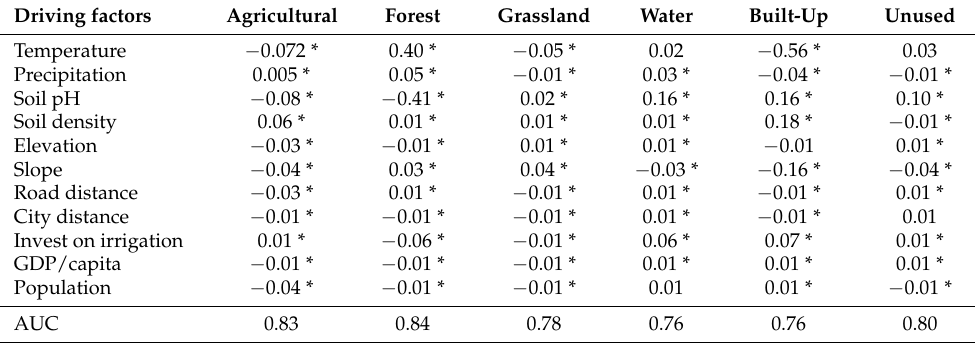
Table 3. Statistical description of the coefficients of influencing factors of land. Driving